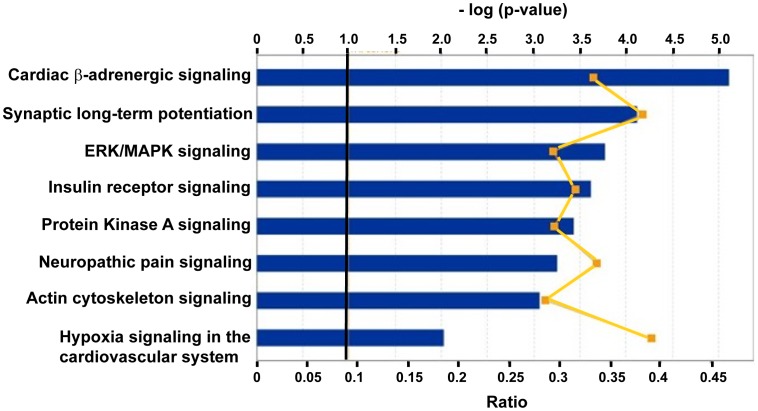
Most significant predicted canonical pathways regulated by the target genes of the 3 miRNAs: 376a, 409-3p and 1225-3p (p-value<0.01).Orange squares depict ratio which is the number of target genes associated with each pathway. The vertical line across the bars represents the cut-off of the p-value.